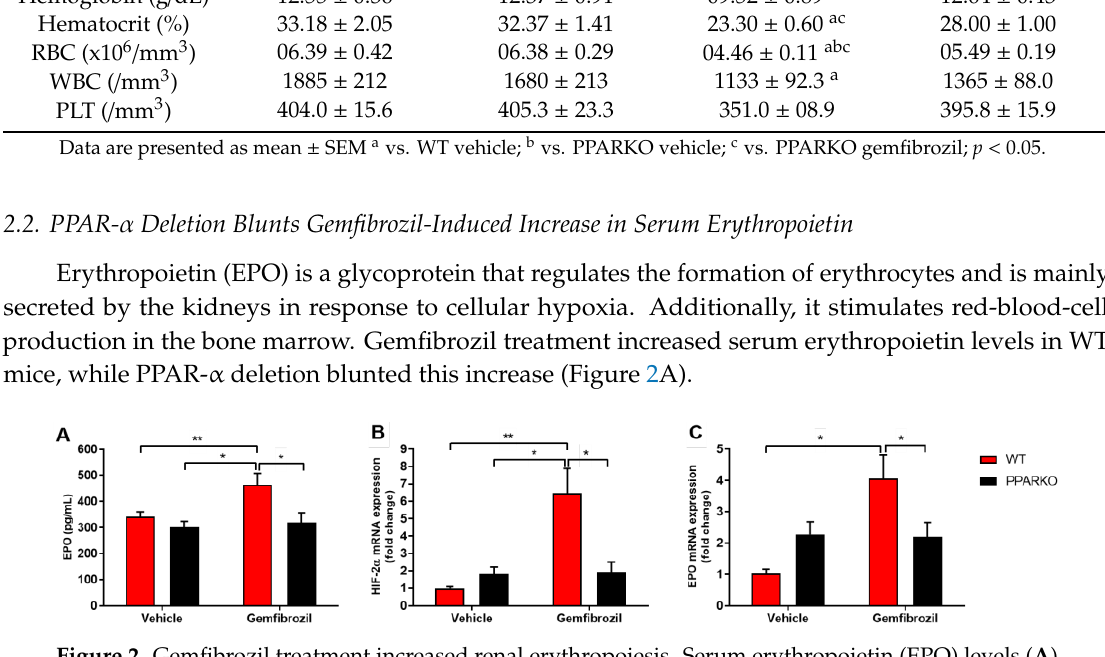
Figure 1. Hemoglobin levels during gemfibrozil treatment. The panel shows the hemoglobin levels at 7 different times over 21 days in WT mice. Data are presented as mean ± SEM; n = 6. One-way ANOVA) followed by Dunnett’s post hoc test. ** p < 0.01. Table 1. PPAR-alpha deletion reverses decreasement of blood count parameters. WT PPARKO WT PPARKO Parameters Vehicle Vehicle